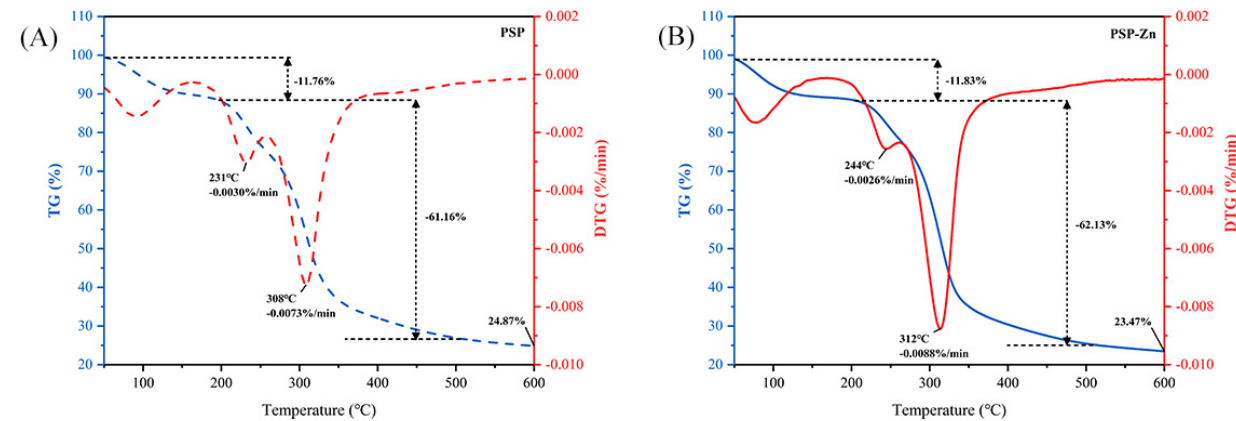
Figure 2. Thermogravimetric curve of ( A ) PSP and ( B ) PSP − Zn.